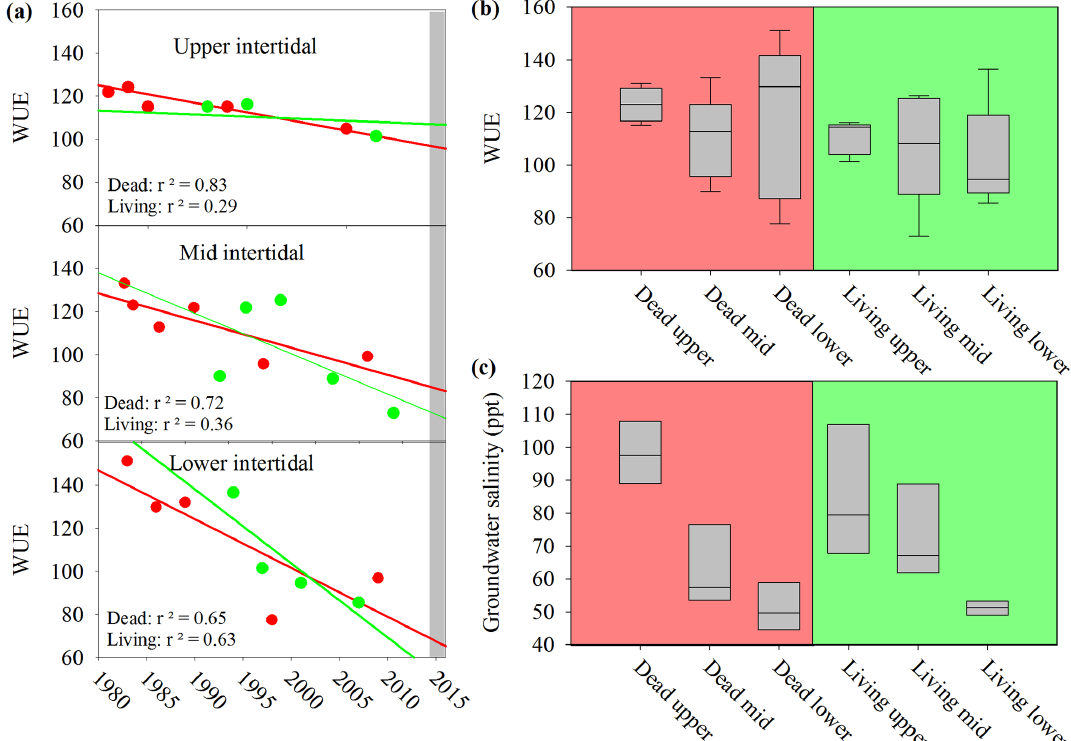
Figure 7. (a) Changes in the water use efficiency (WUE) over time in wood samples collected from the upper, lower and mid intertidal zone in living (green) and dead (red) mangrove areas. The grey bar represents the mangrove dieback event. Error bars are not visible due to the low error of individual samples. (b) Box plot of the water use efficiency in mangrove wood samples in dead and living mangrove areas in the upper, mid and lower intertidal zones. The sample size is greater than four from each wood sample. The central horizontal line represents the median, the box represents the upper and lower quartiles, and the whiskers represent the maximum and minimum values. (c) Box plot of groundwater salinity 8 months after the dieback event in the dead and living mangrove areas in the upper, mid and lower intertidal zones. The sample size is greater than three from each intertidal